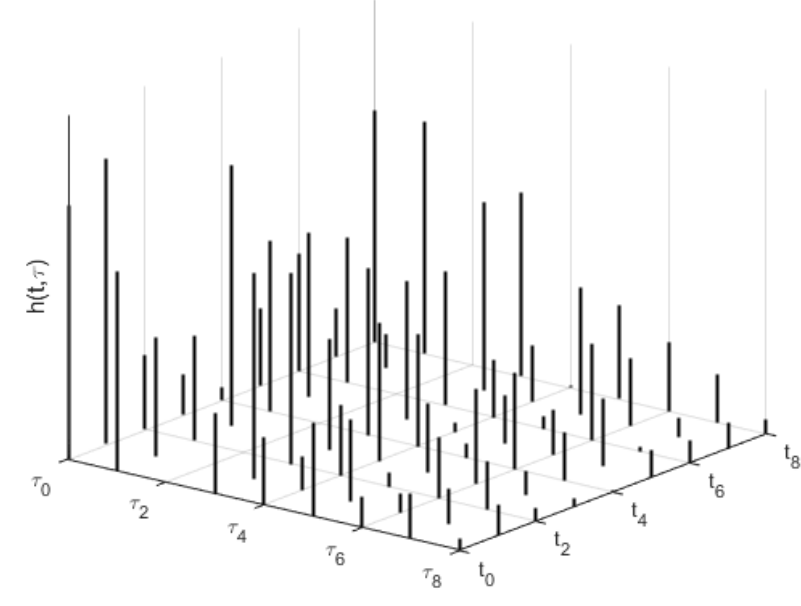
Figure 3. Simulation for a mathematical model of the multipath impulse